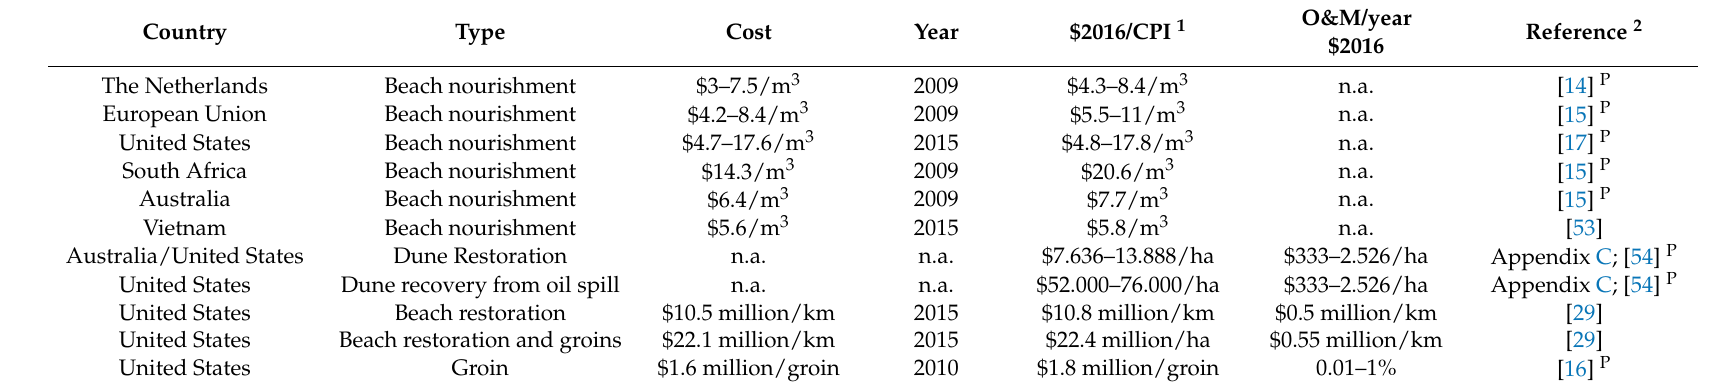
Table 5. Cost of coastal protection by beaches and